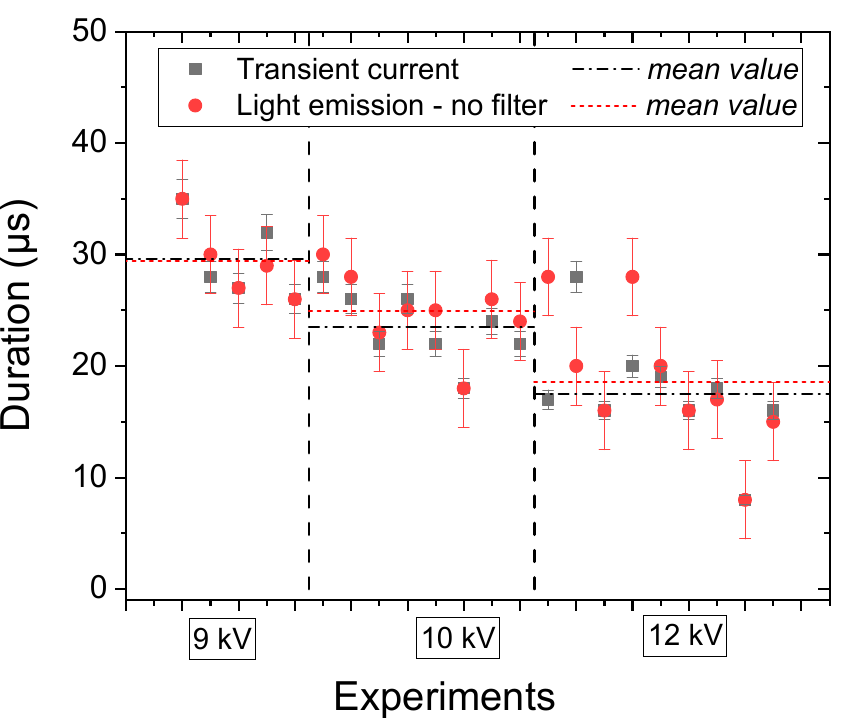
Figure 3. Comparison of duration of the transient current and the total light emission.